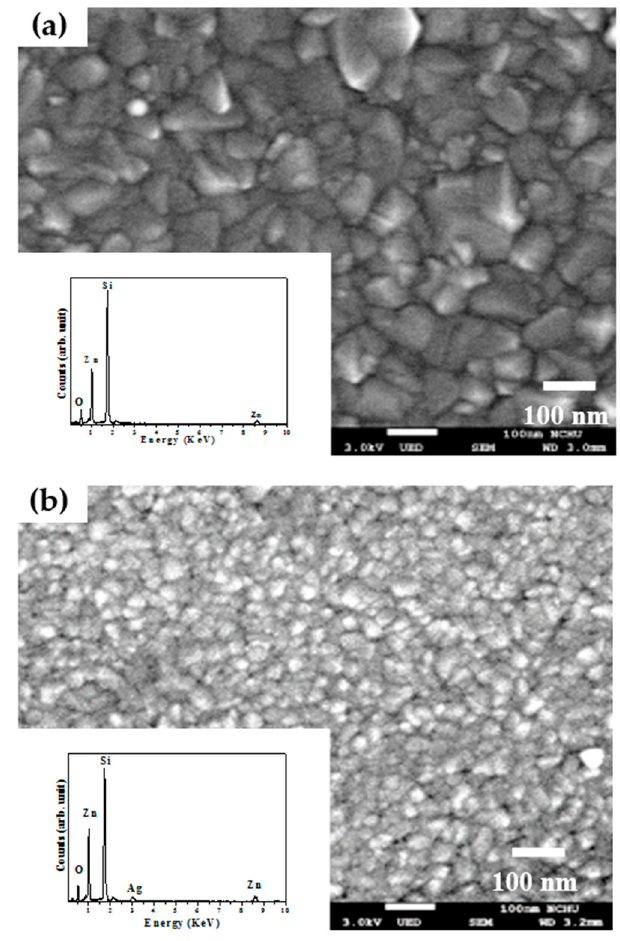
Figure 4. Surface morphologies of the ( a ) undoped ZnO film and ( b ) Ag-ZnO co-sputtered film at a theoretical atomic ratio of 3% after annealing at 350 °C for 1 h under ambient air (the inset figures shows the elemental compositions conducted from EDS measurement).